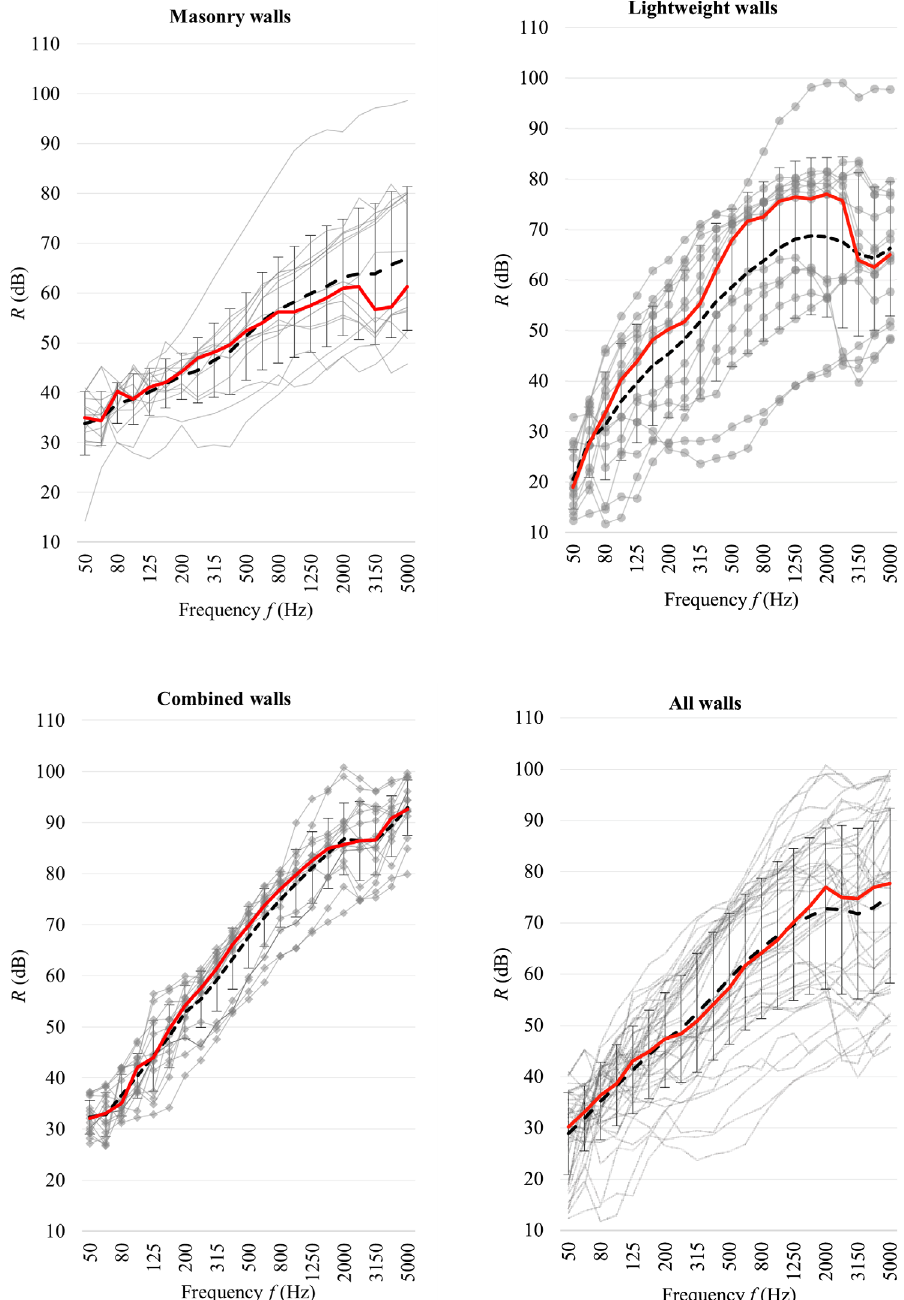
Figure 3. Sound reduction index R (dB) of all considered walls (grey curves), average spectrum (dashed black curve) with standard deviation (error bars) and median spectrum (red curve). The 4 panels show the spectra for masonry walls (top left), lightweight walls (top right), combined walls (bottom left) and all walls together (bottom